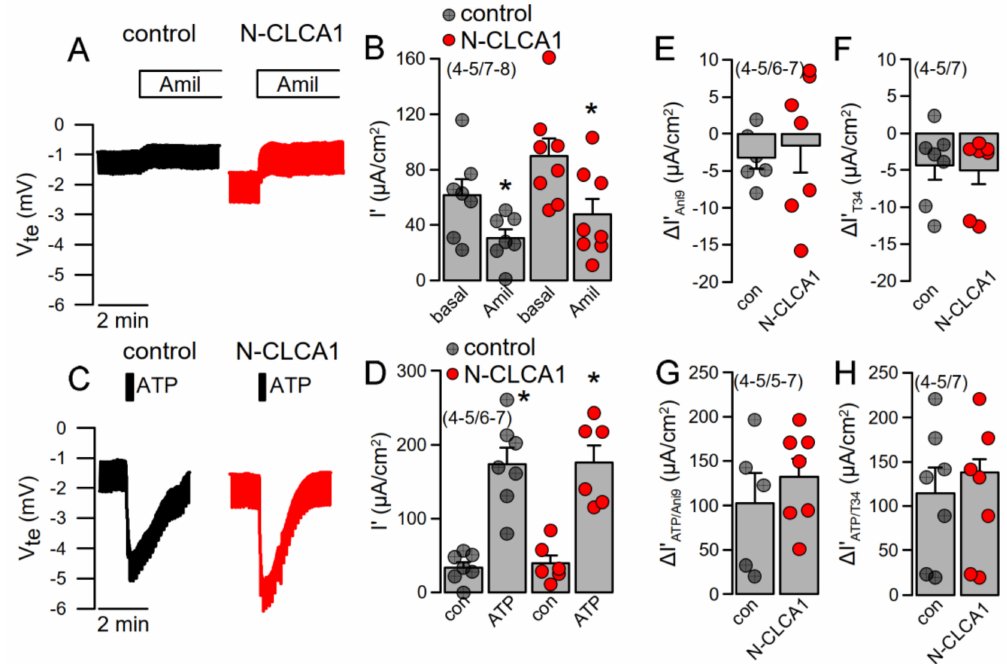
Figure 3. N-CLCA1 does not induce additional Ca 2+ -activated Cl − secretion in mouse tracheas. ( A , B ) Original Ussing chamber recording of the transepithelial voltages measured in mouse trachea under open circuit conditions and summary of the calculated equivalent short circuit current (Isc’). No significant changes in amiloride-sensitive (10 µ M) Na + absorption was detected by 24 h exposure to N-CLCA1. ( C , D ) No significant changes in ATP (luminal; 100 µ M)—induced negative voltage deflection and ATP-activated Isc’ was detected by N-CLCA1. ( E , F ) N-CLCA1 did not induce an effect of Ani9 (10 µ M) or TRAM-34 (100 nM) on basal currents. ( G , H ) Effects of ATP in the presence of luminal Ani9 or basolateral TRAM-34 (T34) were independent of N-CLCA1. Mean ± SEM (number of animals/number of experiments). *—significant effect of amiloride and ATP ( p < 0.05; paired t